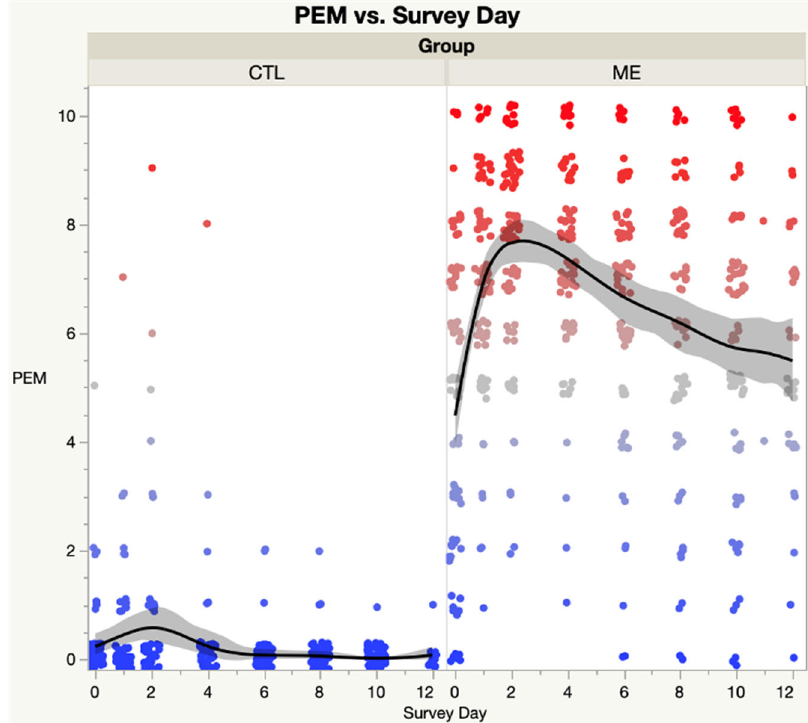
Figure 3. Post ‐ Exertional Malaise (PEM) domain score of SSS instrument—ME/CFS vs. CTL. The shaded area represents the 95% confidence interval. Each dot represents the PEM score for a single subject; Blue dots are low scores, red dots are high scores; Black lines represent the spline curves for group averages; Grey shaded areas are the 95% confidence intervals.